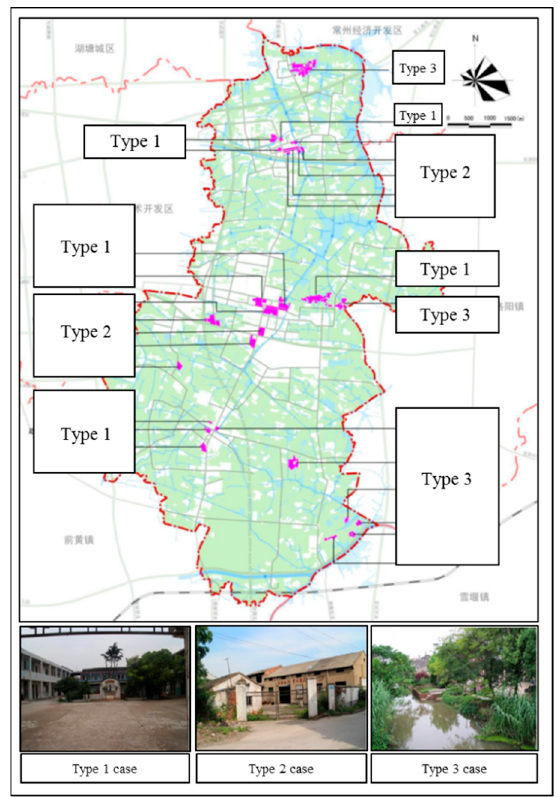
Figure 4. Three types of stock land that can be transformed into mobile resources during master planning in Lijia. planning in